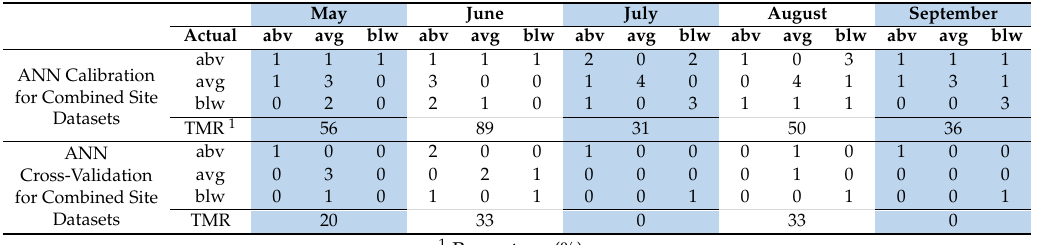
Table 7. Confusion matrices from ANN calibration and cross-validation, showing actual and predicted class membership for the months May through September for the GRL site. AGFM classes are above average (abv), average (avg), and below average (blw) above-ground forage biomass. The total misclassification rate (TMR) for each month is also shown, and is calculated as the number of misclassifications divided by the total number of